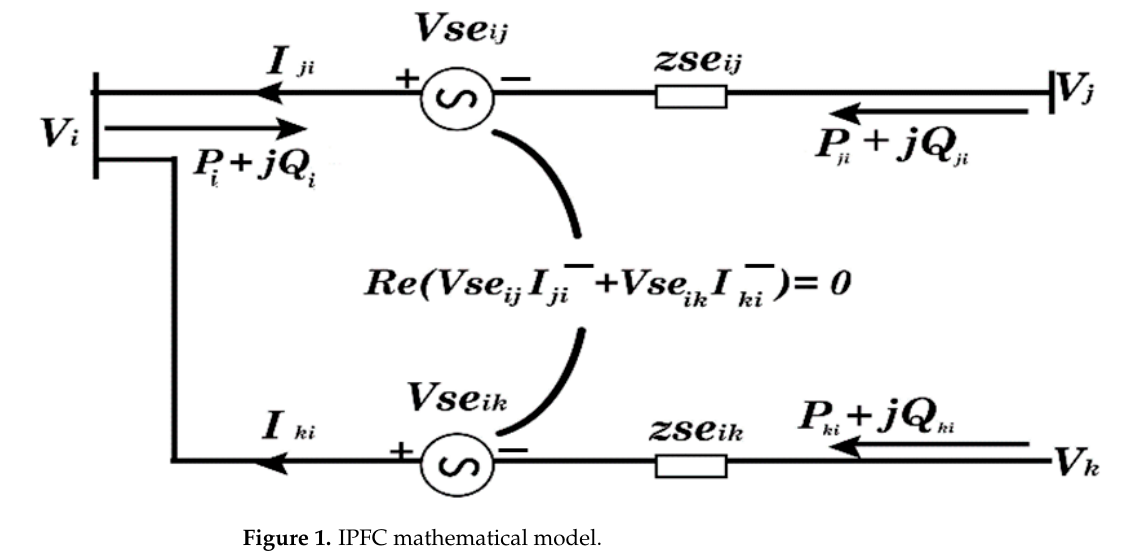
Figure 1. IPFC mathematical model.